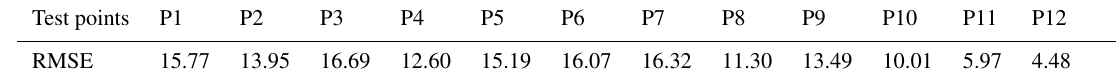
Table 2. The RMSE of the 14 validation points.